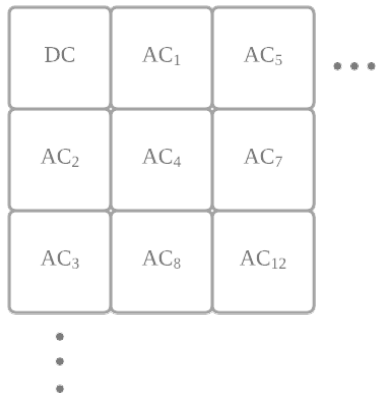
Figure 3. The naming convention adopted in this work for DC and AC coefficients. AC 1 , AC 2 , and AC 3 are adopted for data